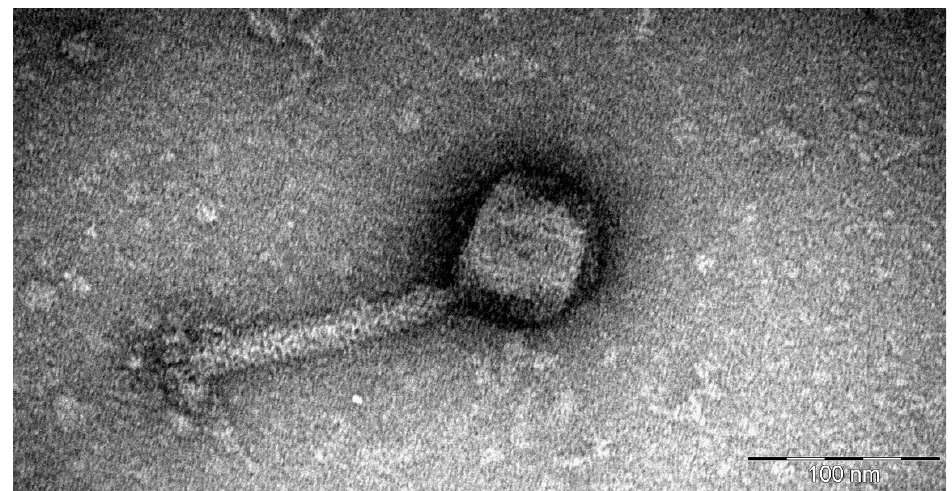
Figure 2. The transmission electron micrograph demonstrating the morphology of the Morganella bacteriophage Mecenats66 virion negatively stained with 0.5% uranyl acetate.